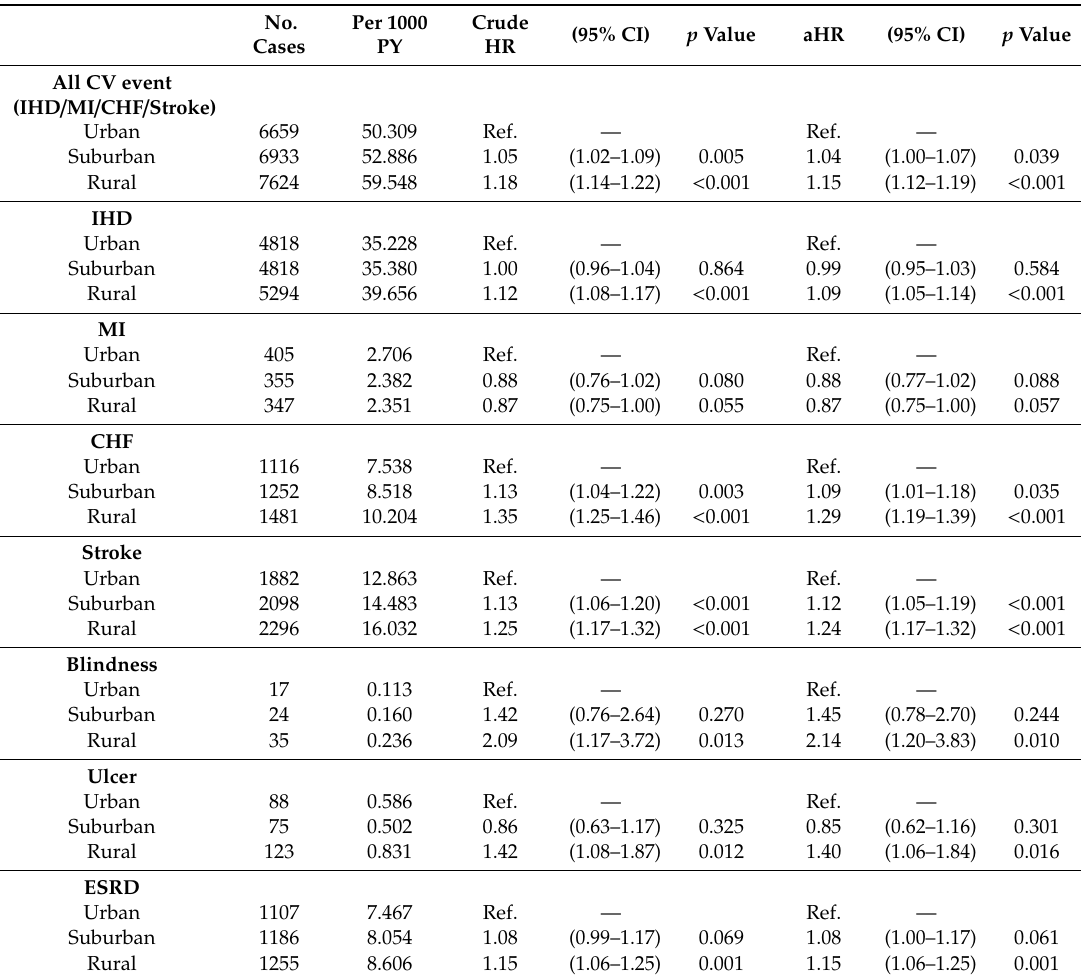
Table 2. The adjusted hazard ratio (aHR) of complications of diabetes mellitus (DM) patients among di ff erent levels of